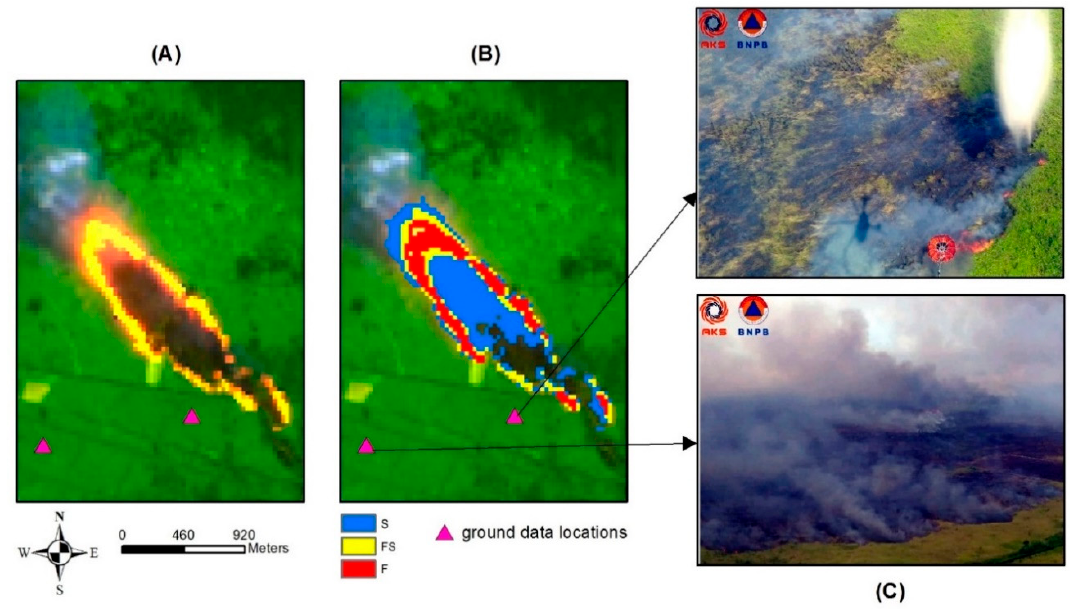
Figure 9. ( A ) The 764 RGB image of Landsat-8 on 28 September 2018, ( B ) The result of ToPeCAl mapping which consists of smouldering (S), mixture of flaming and smouldering (FS), and flaming (F) with ground truth base station locations marked in magenta triangle, ( C ) The pictures of peatland fires taken from helicopter on 28 September 2018. Field pictures sourced from the local Indonesian Disaster Management Agency (BNPB) of Central Kalimantan Province.